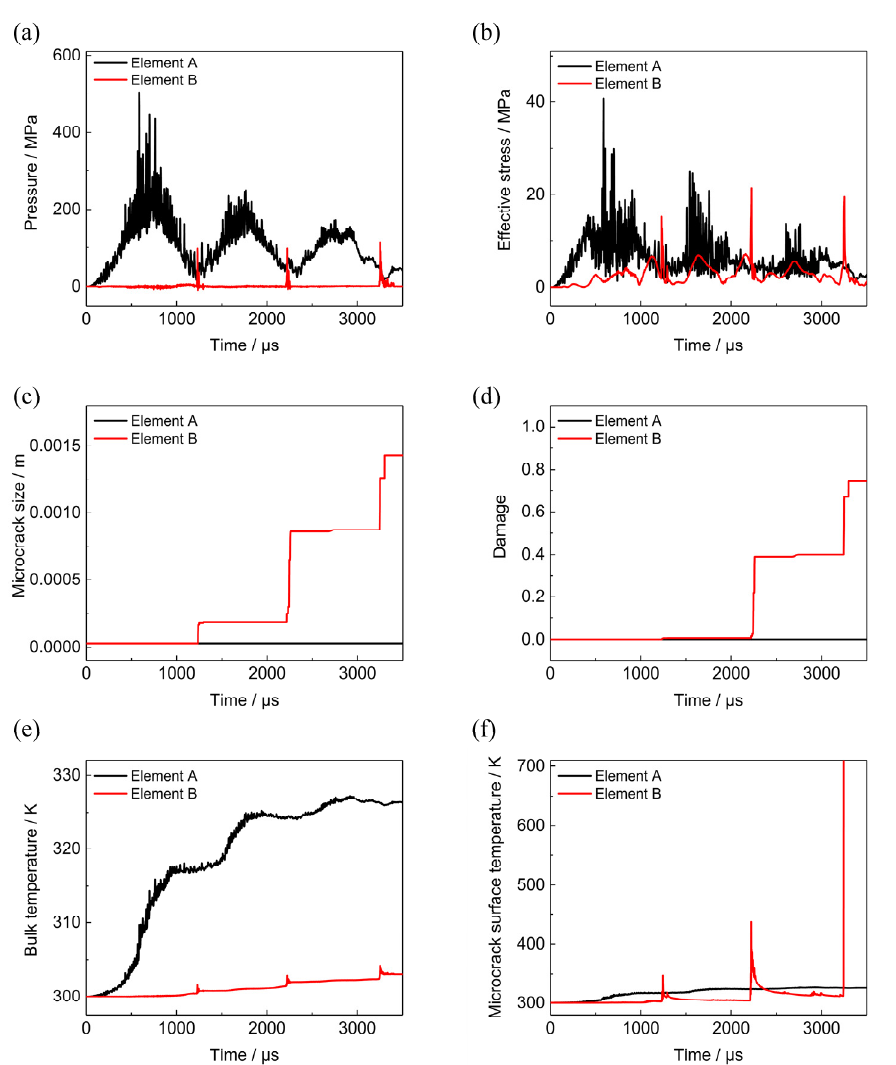
Figure 17. History curves of several variables of Element A and B. ( a ) Pressure. ( b ) Effective stress. ( c ) Microcrack size. ( d ) Damage. ( e ) Bulk temperature. ( f ) Microcrack surface temperature.